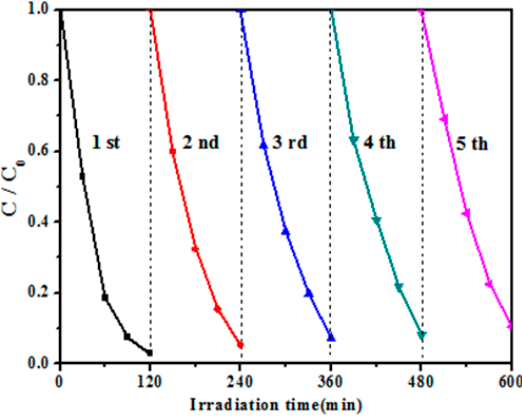
Figure 10. Cycling runs in the PEC degradation of TC·HCl over the TiO 2 NTs/Ag/MoS 2 .